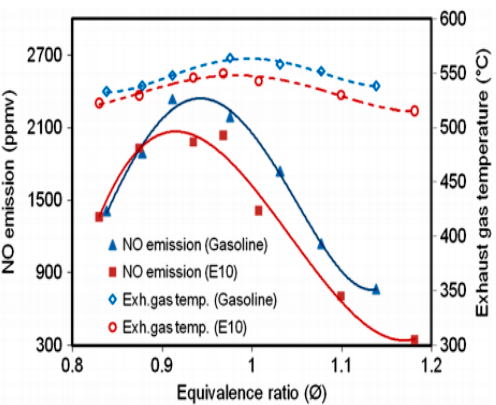
Figure 7. NO emission and exhaust gas temperature versus equivalence ratio, for a fixed speed of 2500 rpm and a 25% throttle opening. Reprinted (adapted) with permission from Ref. [67]. Copyright (2012) John Wiley and Sons.